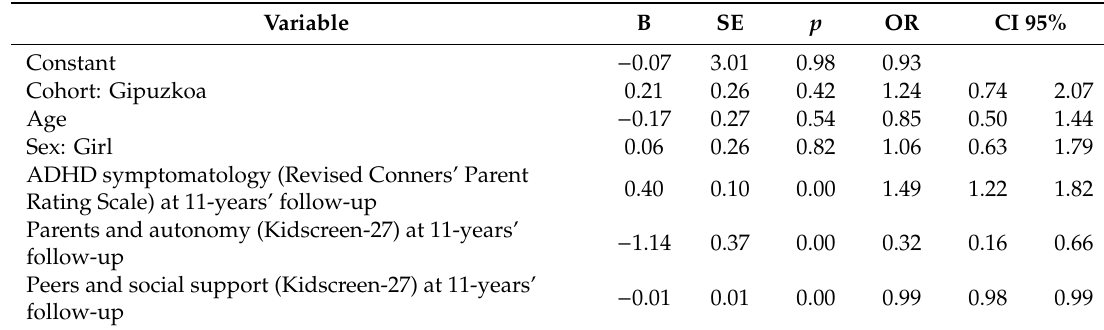
Table 2. Predictors of being a victim for the whole sample.